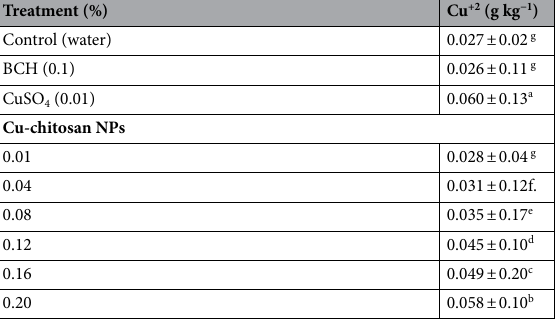
Treatment (%) Cu +2 (g kg −1